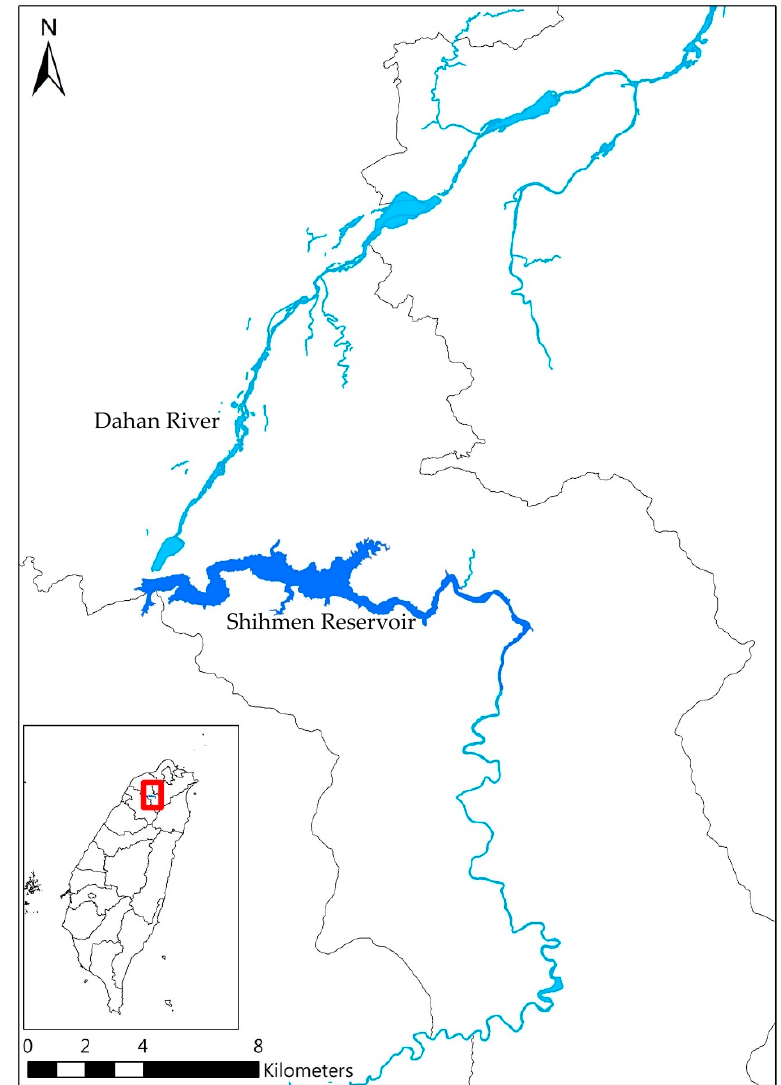
Figure 2. Shihmen Reservoir and Dahan River.